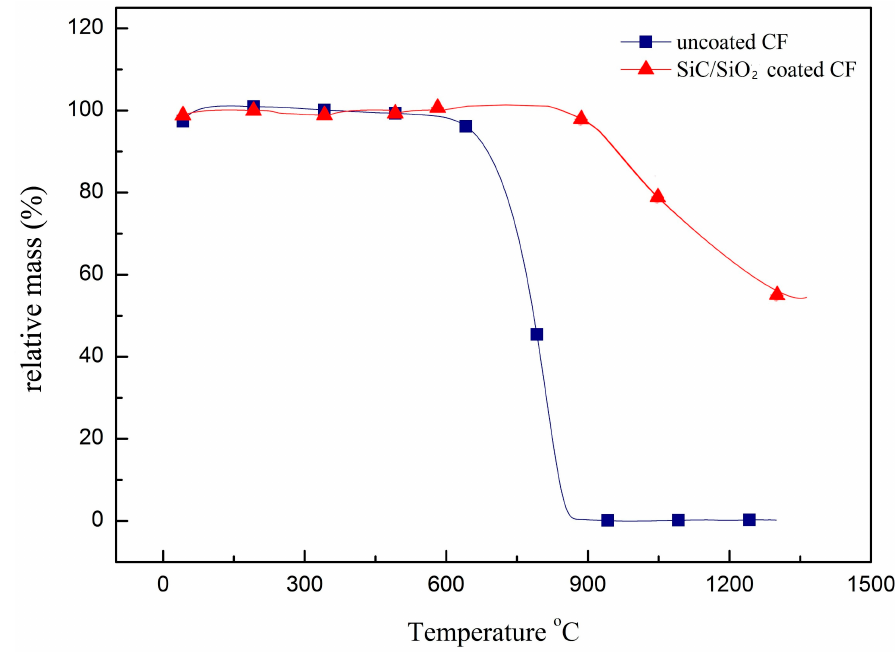
Figure 7. Thermal Gravimetric (TG) curves of uncoated CF and SiC/SiO 2 coated CF.